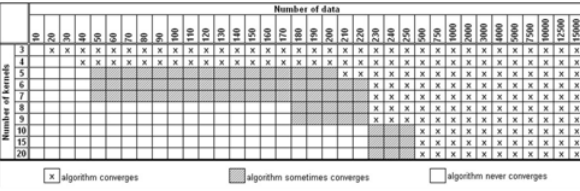
Table 2. Configurations of the FGM where collapsing of the EM algorithm is observed.